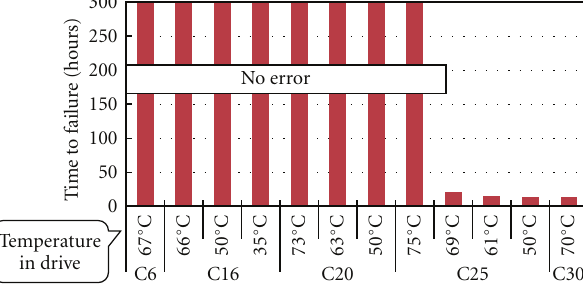
Figure 10: Alkane injection test result. The tests over 300h were